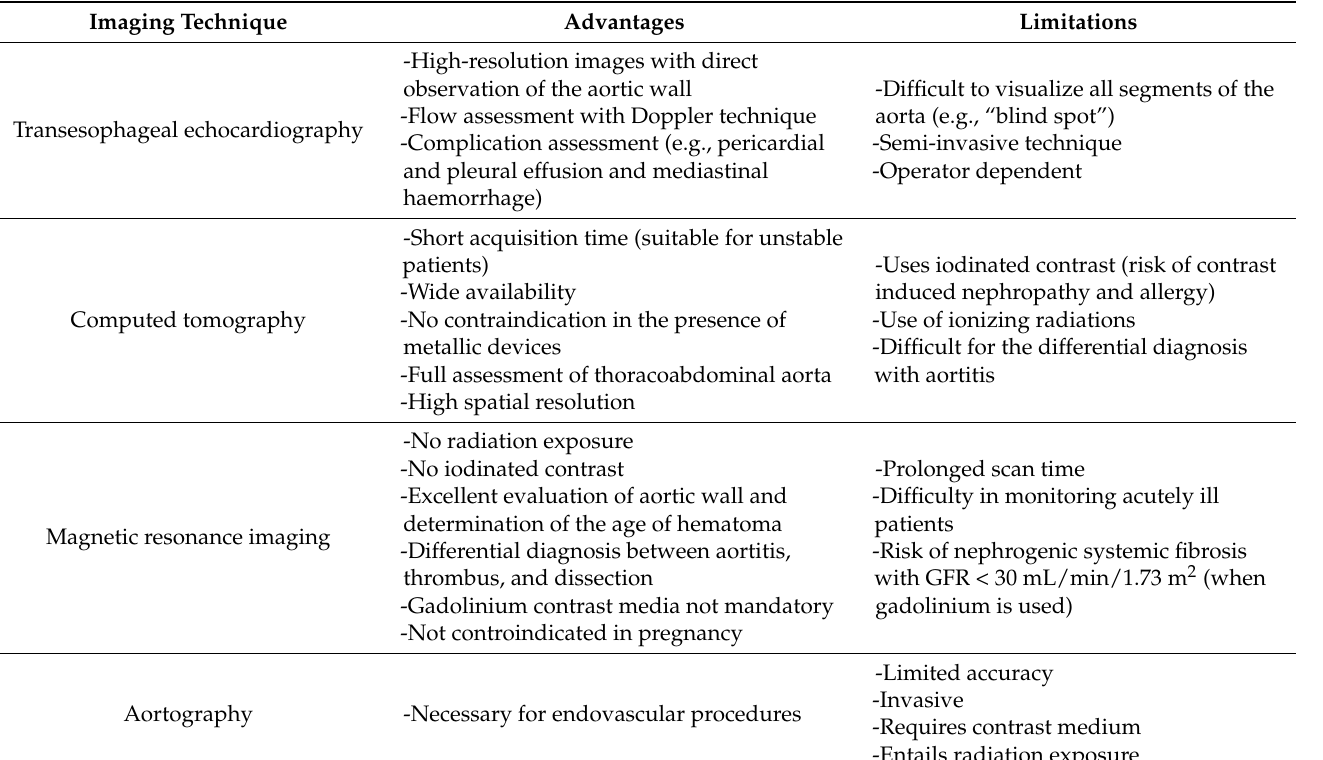
Table 2. Advantages and limitations of imaging techniques in the diagnosis of intramural hematoma.